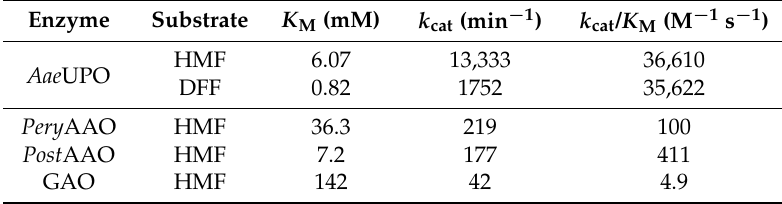
Table 1. Apparent catalytic constants (Michaelis-Menten constant, turnover number, specific constant) of three fungal oxidases (AAO, GAO) and an unspecific peroxygenase (UPO) for HMF and DFF oxidation at pH 6.0.